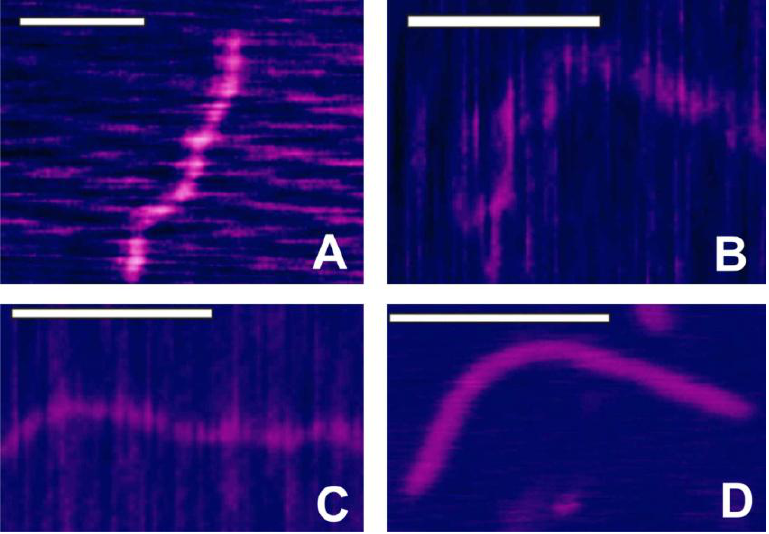
FIGURE 1 . Noncontact, tapping mode, AFM images of DNA obtained from M. hominis PG37 (A, B) and A. laidlawii PG8 (C, D) cells in air. Note: the vegetative forms (A, C) and VBNC forms (B, D) are shown. The presented images were recorded in height regime. Bars correspond to 100 nm.